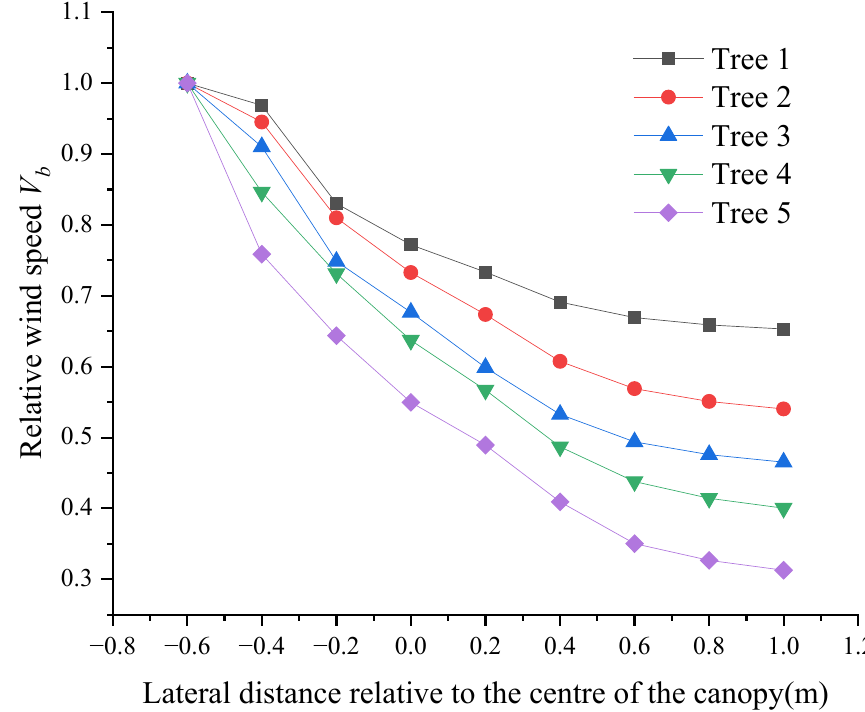
Figure 7. Relative wind speed in front of and behind the trees at the centre of the canopy.